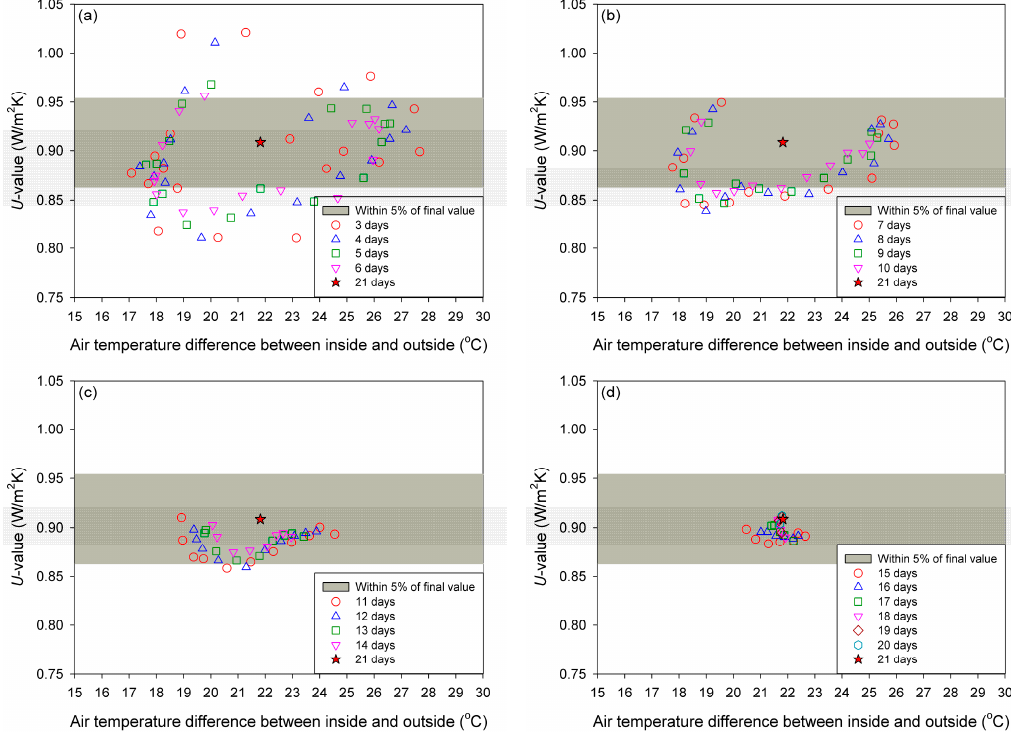
Figure 10. Relationship between average air temperature differences and final U -values evaluated for different analysis periods. For ease of understanding, the plots are divided into four sub-figures based on the length of the analysis period: ( a ) 3–6 days; ( b ) 7–10 days; ( c ) 11–14 days; ( d ) 15–20 days.